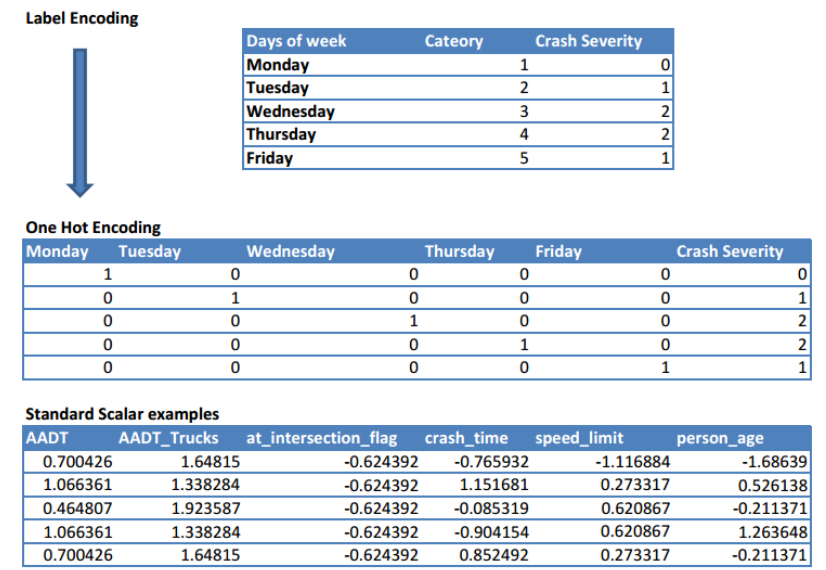
Figure 6. The coding and the standard scalar examples in this machine learning process.